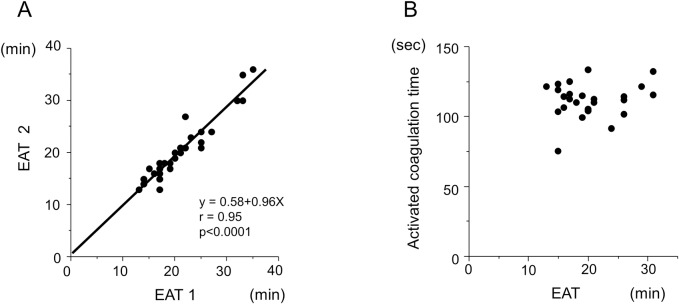
Reproducibility and interchangeability of the DBCM analysis.(A) The within-run reproducibility of the EAT is assessed by the correlation between the first measurement of the EAT (EAT1) and second one (EAT2) in healthy subjects (n = 40). The time interval between the first and second measurements was 3 to 5 minutes. The EAT at the time of the two measurements had a high reproducibility (y = 0.58 + 0.96x, r = 0.95, p <0.0001). (B) The interchangeability between the EAT and activated coagulation time (ACT) was evaluated by a simple regression analysis (n = 25). The EAT shows no significant correlation to the ACT.